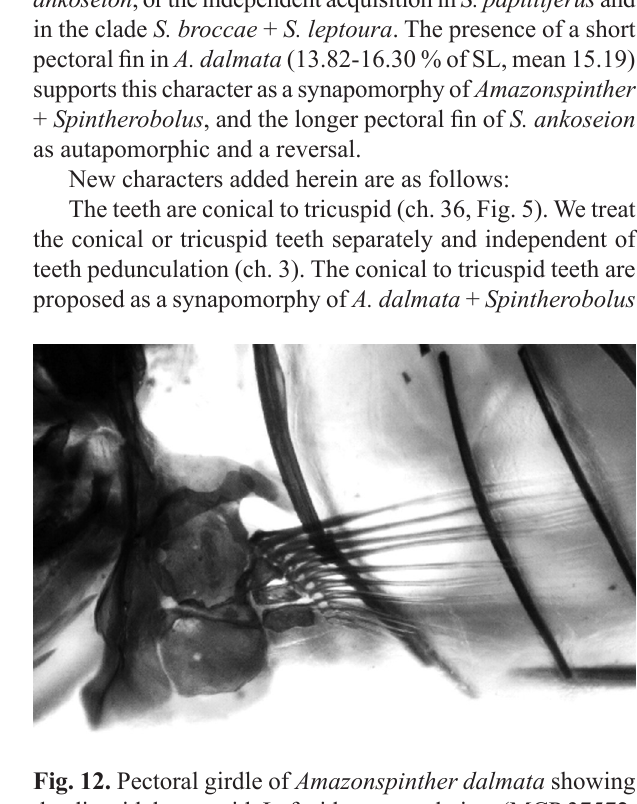
Fig. 11. Infraorbitals and antorbital of Amazonspinther dal- mata (MCP 37572, CP: 14.98 mm, right side).